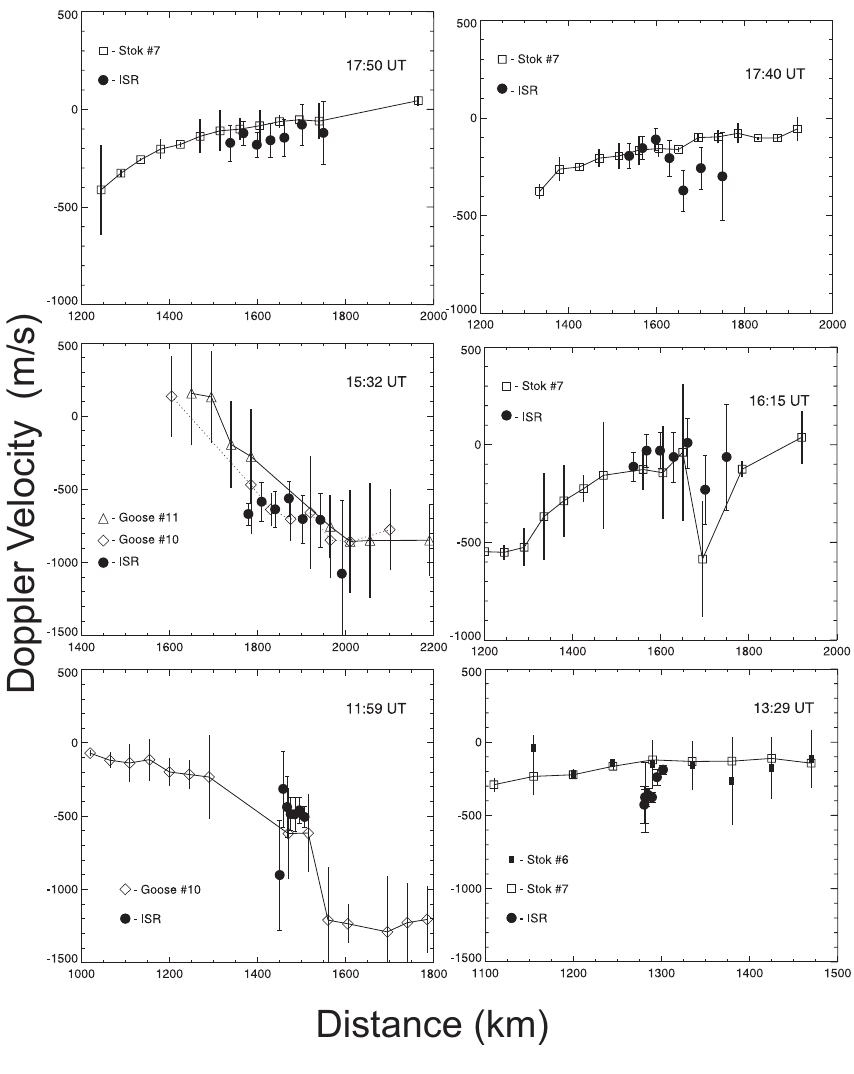
Fig. 5. Comparison of range profiles for the HF l-o-s velocity (squares, trian- gles and diamonds) and incoherent scat- ter l-o-s velocity (solid circles) on 10 March 1998. For clarity, error bars are increased by four times. Indicated time corresponds to the moments of the Son- drestrom measurements; SuperDARN data are obtained within 1 min from the marked